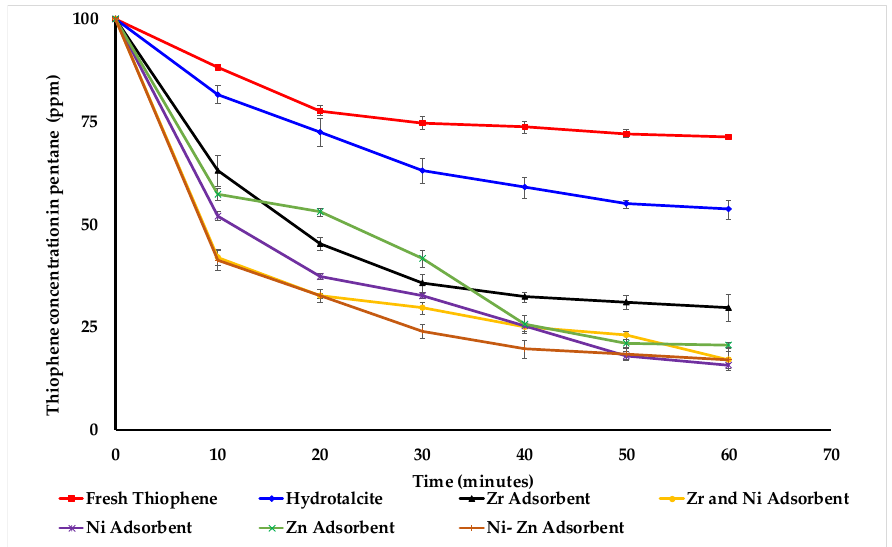
Figure 7. Thiophene concentrations in pentane with time.